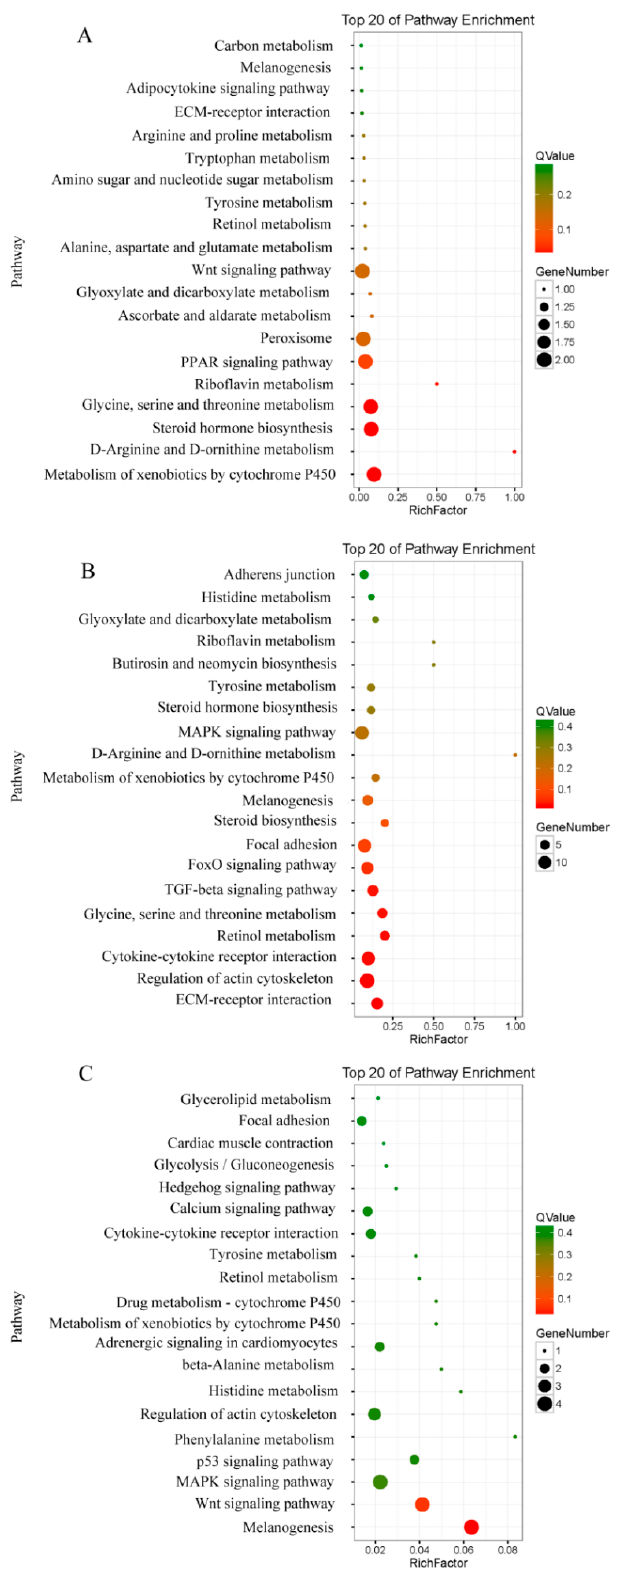
Figure 3. KEGG pathway enrichment analysis of codifferential genes in the three comparison groups. ( A ) The top 20 of enriched pathways in the TK14 vs. TK15 comparison group. ( B ) The top 20 enriched pathways in the TK14 vs. TK16 comparison group. ( C ) The top 20 of enriched pathways in the TK15 vs. TK16 comparison